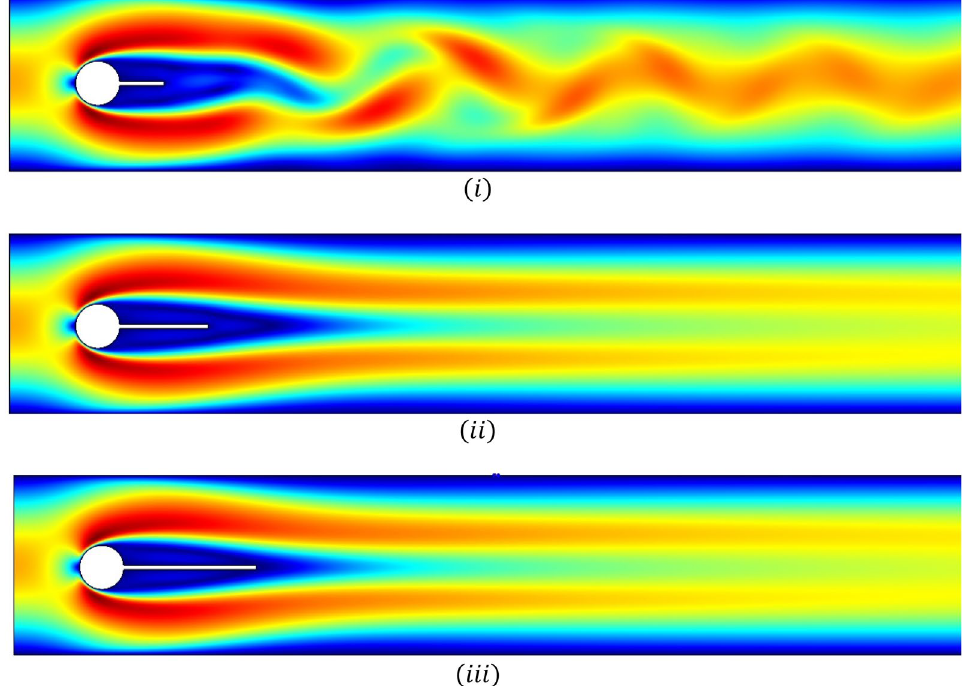
Figure 5. Influence of attached splitter plates on velocity, of lengths ( i ) L 1 = 0.1, ( ii ) L 2 = 0.2, ( iii ) L 3 = 0.3 with Re = 100 at t = 10.